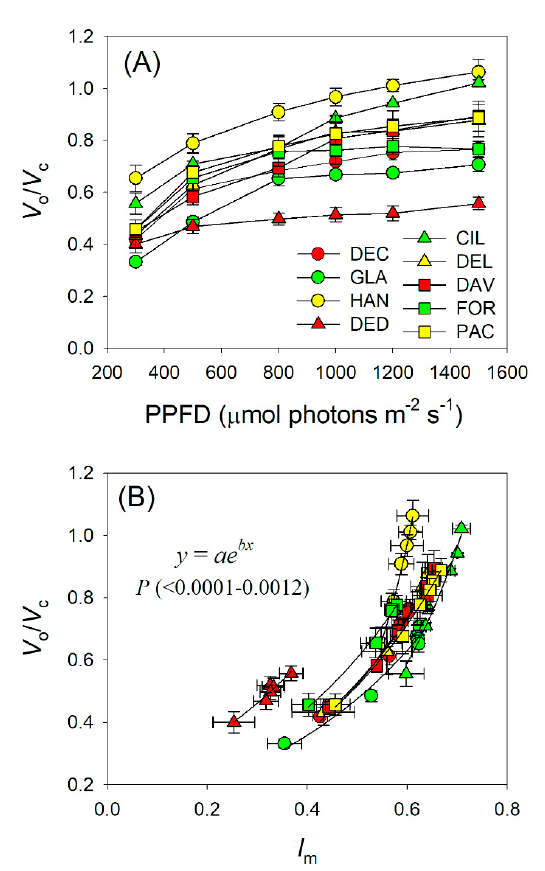
Figure 6. ( A ) Light intensity dependence of the V o / V c ratio in nine Rhododendron species. ( B ) Relationship between l m and V o / V c across light response curves in these nine Rhododendron species. Symbols represent means ± SE ( n = 4–5). Species abbreviations: DEC, R. decorum ; GLA, R. glanduliferum ; HAN, R. hancockii ; DED, R. decorum subsp. disprepes ; CIL, R. ciliicalyx ; DEL, R. delavayi ; DAV, R. davidii ; FOR, R. fortunei ; PAC, R. pachypodum .